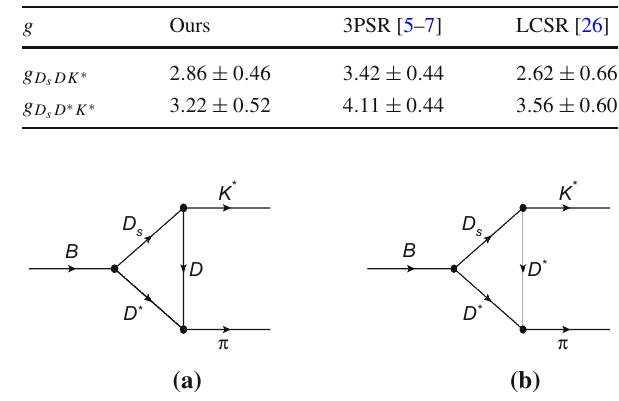
, g K ∗ , g D ∗ and g K ∗ on Q 2 D s DK ∗ D s D ∗ K ∗ D s D ∗ K ∗ D s DK ∗